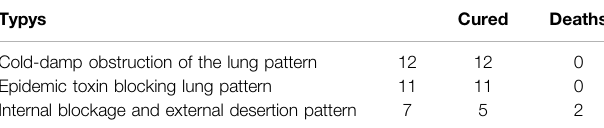
TABLE 4 | Effect of formula on each diagnostic category in the treatment